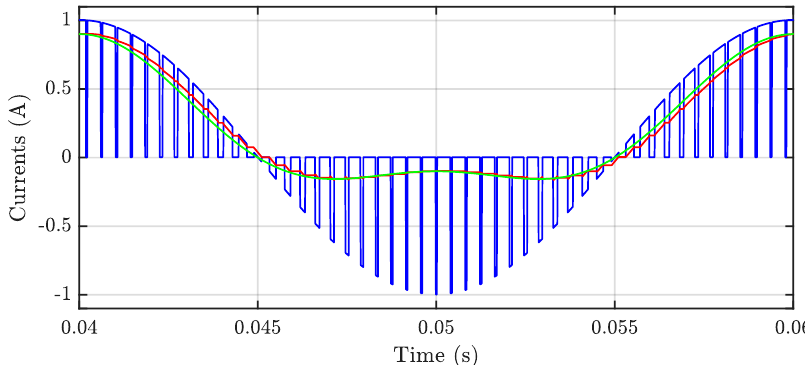
Figure 4. Input current: instantaneous value (blue), its averaged value over the switching period (red), and calculated value (green) in case of single-phase unbalance for m = 0.4, I = I a = 1 A and ϕ = 0°.